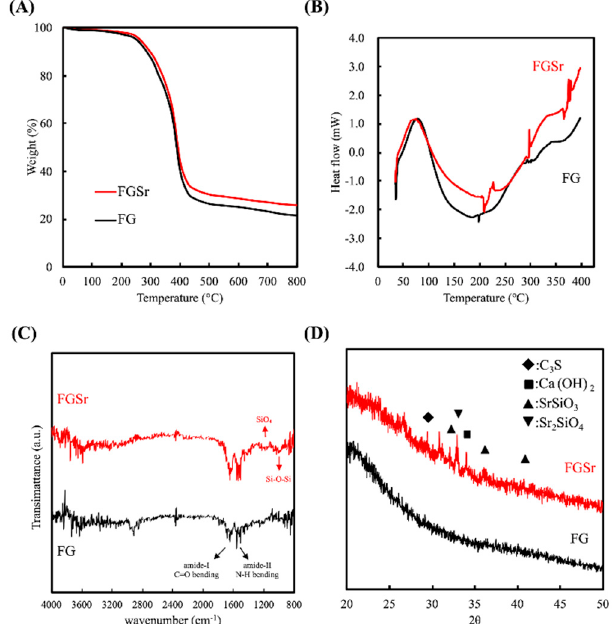
Figure 2. ( A ) TGA, ( B ) DSC, ( C ) FTIR and ( D ) XRD for specimens prepared with a series of FG and FGSr scaffolds.